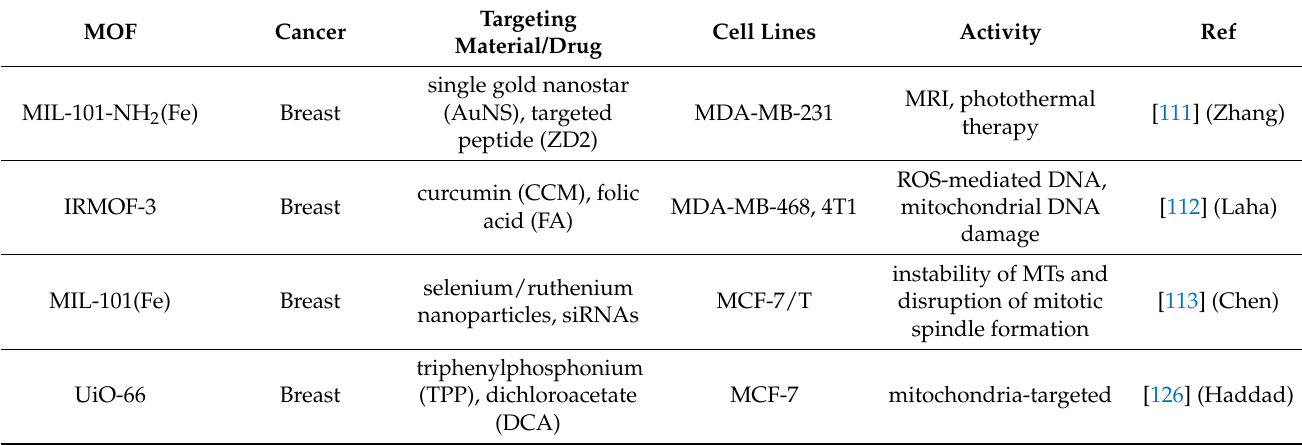
Table 1. Applications of MOF-based nanomaterials for the treatment of different types of cancers. MOF Cancer